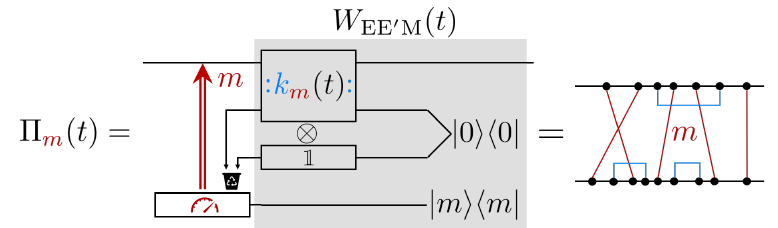
Figure 4: Partially conditioned evolution (16b): the list of modes m that have inter- acted with the system is communicated (but not the measurement outcomes). The key result Eq. (21b), explained in Fig. 6, demonstrates that this circuit corresponds to the indicated Keldysh diagrams with fixed modes on the red contractions summed over all possible blue